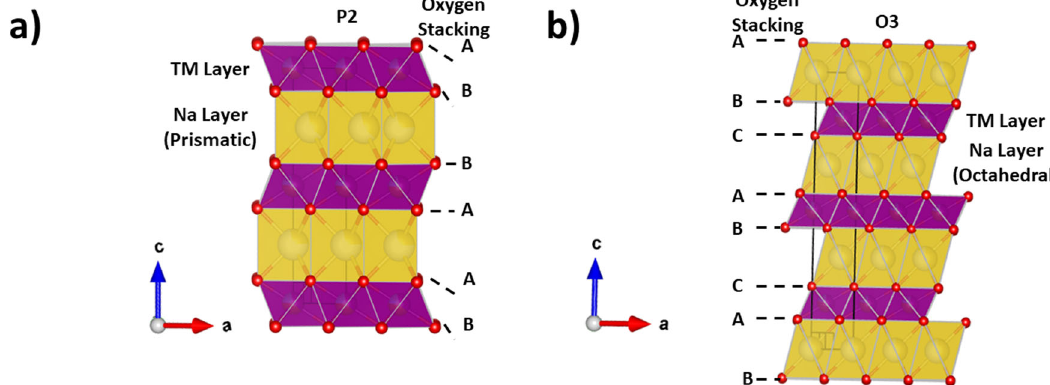
Fig. 1 Schematic diagram of typical P2 and O3 crystal structures that arise from different oxygen stackings, shown by the ABC labels. a Crystal structure of the P2 phase b Crystal structure of the O3